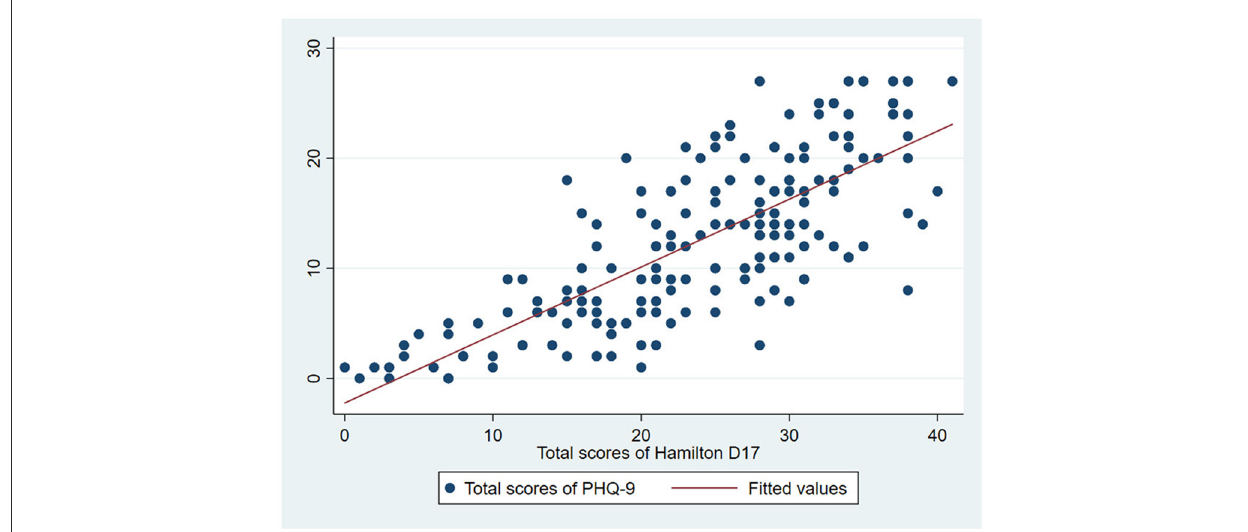
FIGURE3 Correlation between the score of Hamilton D-17 and the score of PHQ-9.